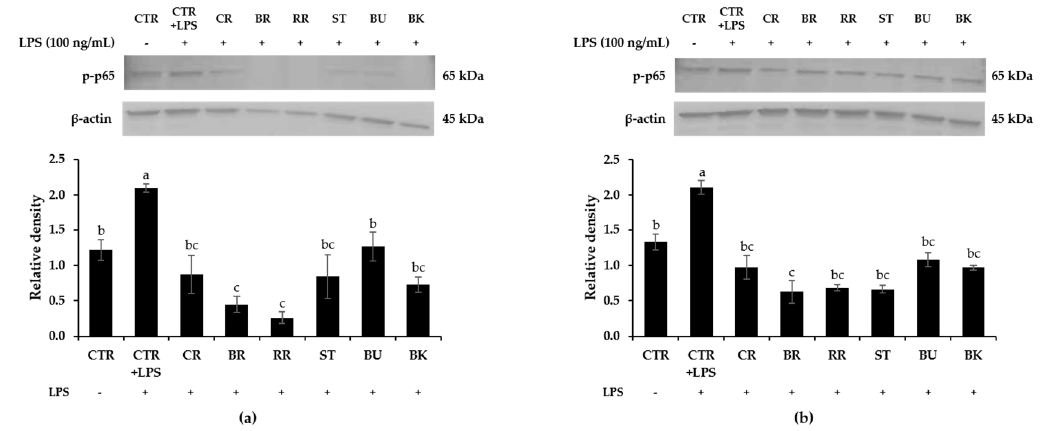
Figure 5. Inhibitory effect of berry ( a ) phenolic and ( b ) volatile extracts (50-fold dilution) on LPS-induced phosphorylation of NF- κ B p65 in RAW264.7 macrophages. Means not sharing any letter are significantly different by the Tukey’s test at the 5% level of significance. CTR = control; CR = cranberry; BR = black raspberry; RR = red raspberry; ST = strawberry; BU = blueberry; BK = blackberry.